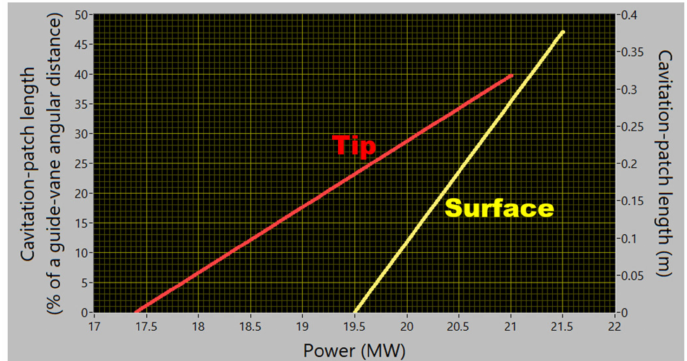
Figure 20. The vibro-acoustical estimation of the average circumferential size of the erosion patches caused by each of the cavitation mechanisms in the two groups of mechanisms.